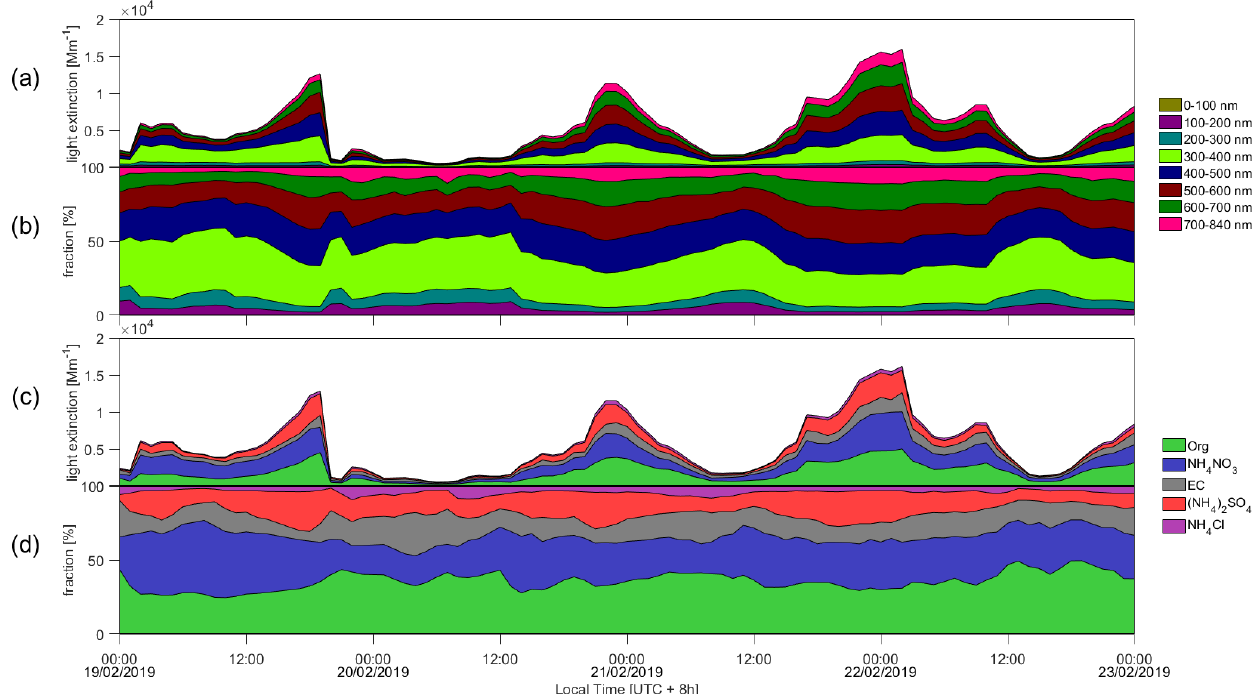
Figure 3. Time series of (a, b) variation of light extinction from different size aerosol and fractions and (c, d) variation of light extinction from different aerosol species and fractions. The legends on the left side of figures are particle diameter, and the right side are chemical compositions, respectively.